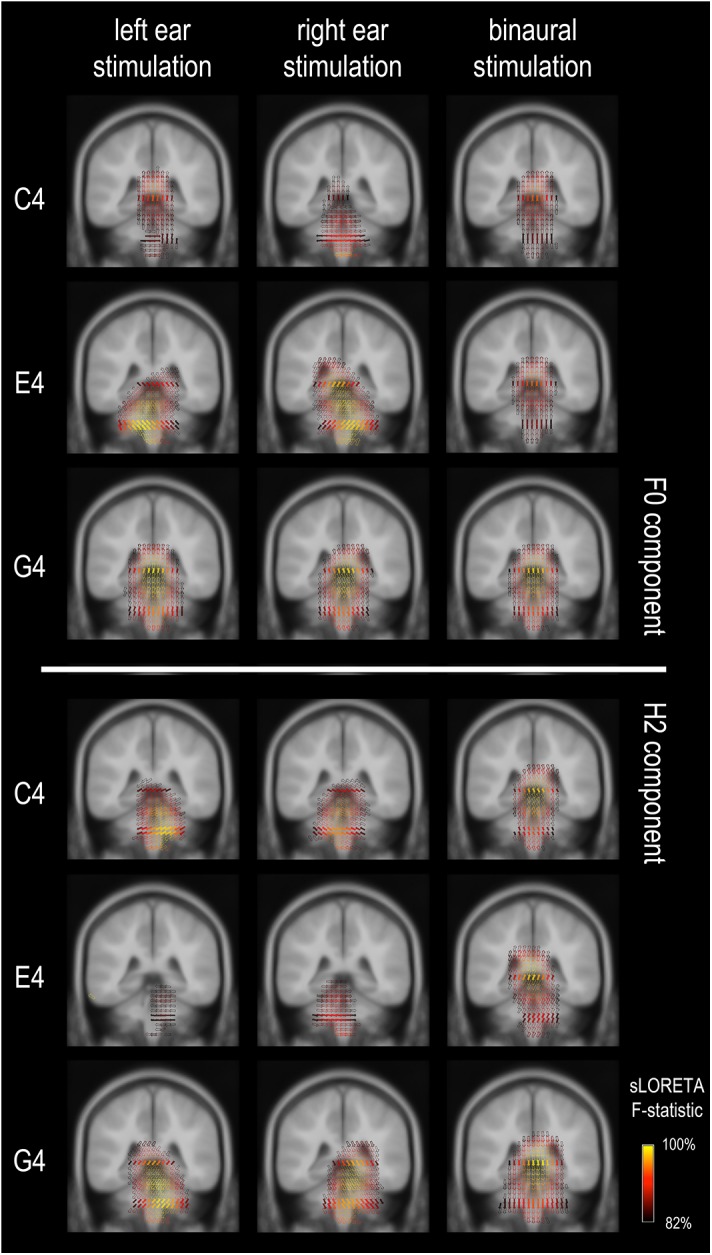
Frequency-following response source imaging. Reconstructed sources of the F0 and H2 components are at subcortical levels, suggesting dominance of subcortical sources for the FFR in response to relatively high stimulus F0s (≥262 Hz). The exact subcortical nuclei from which the FFR originates cannot be determined. The equivalent dipoles (represented by the arrows) point to multiple directions across voxels for the F0 component of the FFR to monaural C4, suggesting high complexity in source configuration. Only sources with a strength larger than 82% of the maximum are displayed; solid arrows refer to the sources exactly on this coronal slice (y = –35), whereas hollow ones refer to those nearby (≤3 mm).